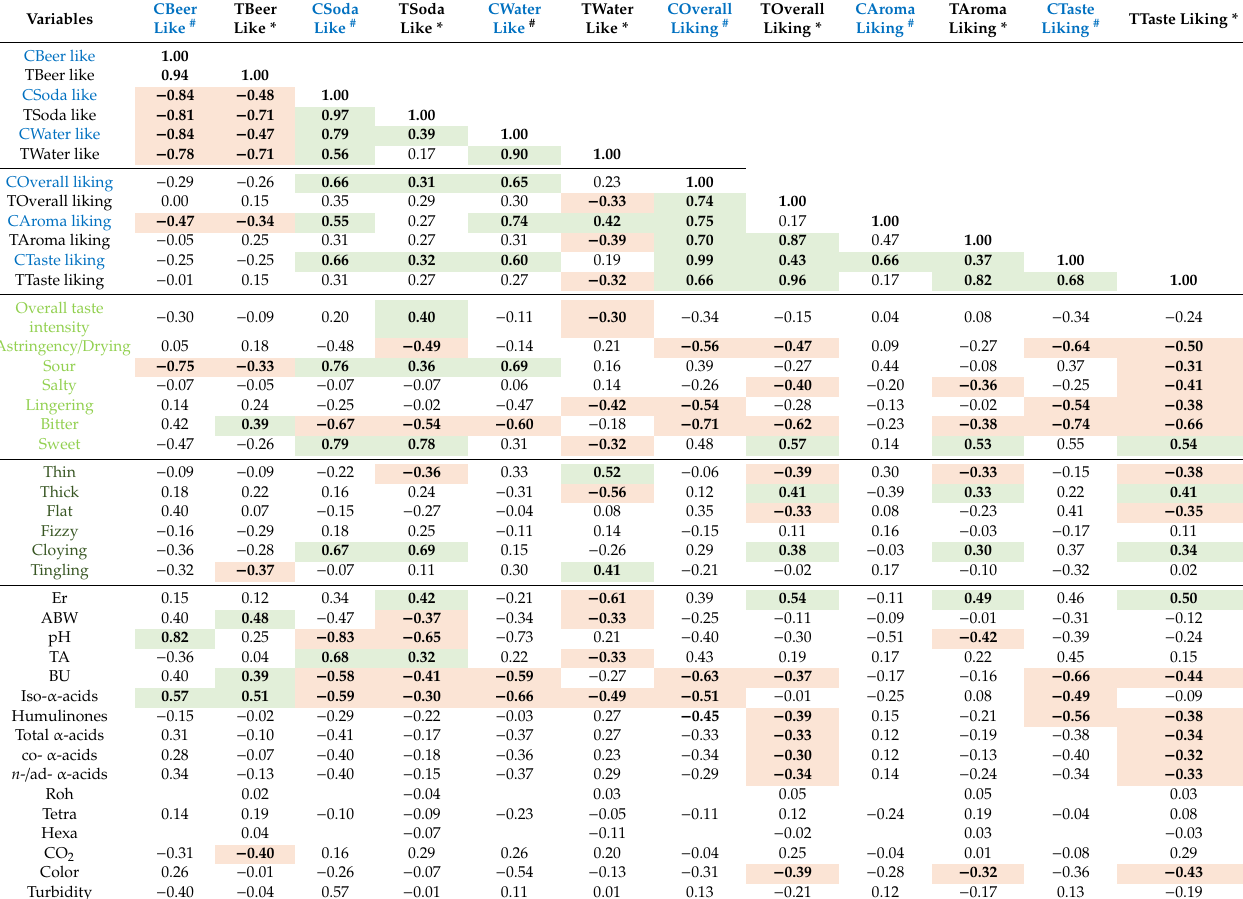
Table 3. Pearson correlation matrix of least square means for both the trained and consumer panel beer, soda, water similarity ratings, hedonic data, taste and mouthfeel attributes, and non-volatile